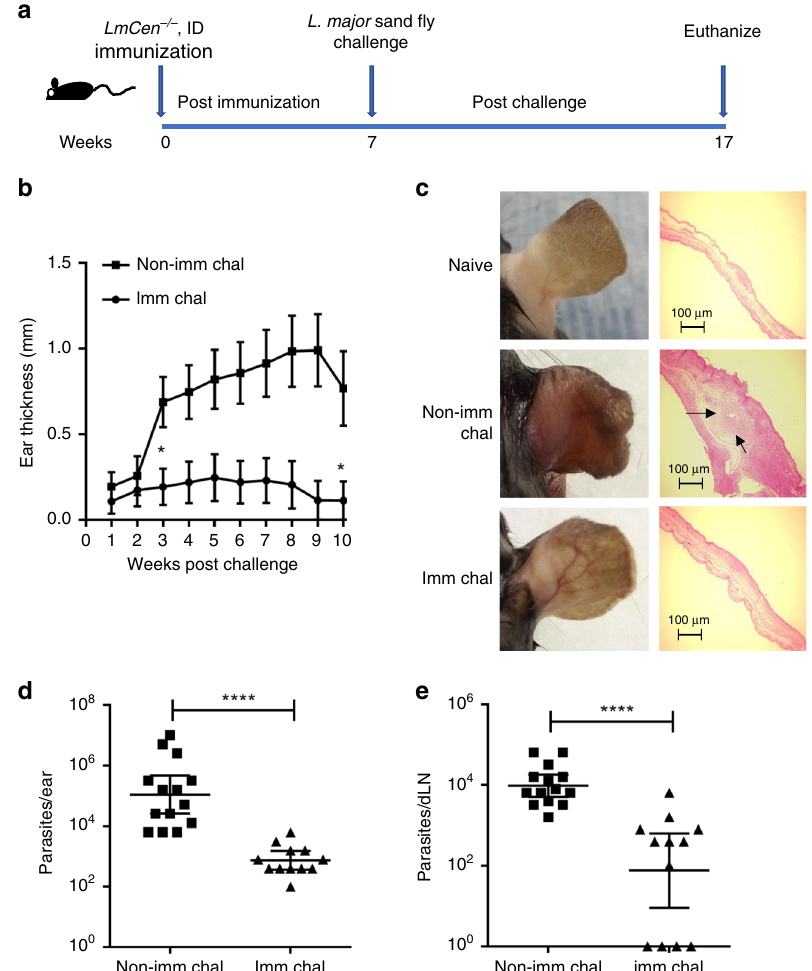
Fig. 5 Protective ef fi cacy of LmCen − / − parasites against sand fl y challenge in C57BL/6 mice. a Schematic representation of the sand fl y challenge procedure. b Ear lesion thickness was measured weekly for both LmCen − / − immunized (Imm Chal) ( n = 12) and non-immunized (Non-Imm Chal) ( n = 14) mice after sand fl y transmission. only 1 mouse out of 12 LmCen − / − immunized-challenged has developed severe lesion. Results are represented as SEM, of 1 ear from each of the 12 – 14 mice per group and data pooled from two independent experiments. Statistical analysis was performed by Mann – Whitney two- tailed test (* p − 0.02). c Photographs (left panel) & histology (H&E staining right panel) of representative ear of age-matched naïve, LmCen − / − immunized (Imm Chal) & non- immunized (Non-Imm Chal) mice after 10 weeks post challenge from one of two independent experiments. Ear histology sections are representative of one mouse from each group of one of two independent experiments ( n = 2). Arrow indicates in fl ammatory cells recruited area. Scale Bars: 100 μ m. Scatter dot plots of parasite load in the challenged ear ( d ) and in the draining lymph node ( e ) of each LmCen − / − immunized (Imm Chal) ( n = 12) & non-Immunized (Non-Imm chal) ( n = 14) mice. Parasite burden was determined by limiting dilution assay. Results are represented as geometric means with 95% Cl of total 12 – 14 mice in each group. Data are pooled from two independent experiments. Statistical analysis was performed by Mann – Whitney two-tailed test (**** p <